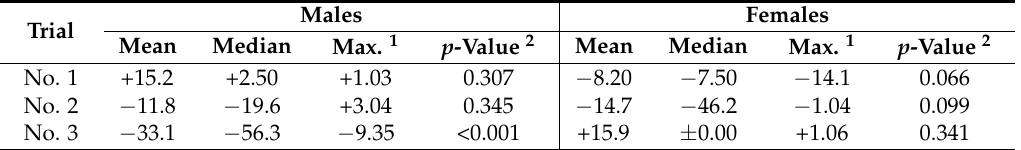
Table 3. Differences in mean, median, and maximum survival rates (%) of male and female w 1118 D. melanogaster in dependence of life-long dietary resveratrol (RESV; 500 µ mol/L) administration compared to controls.